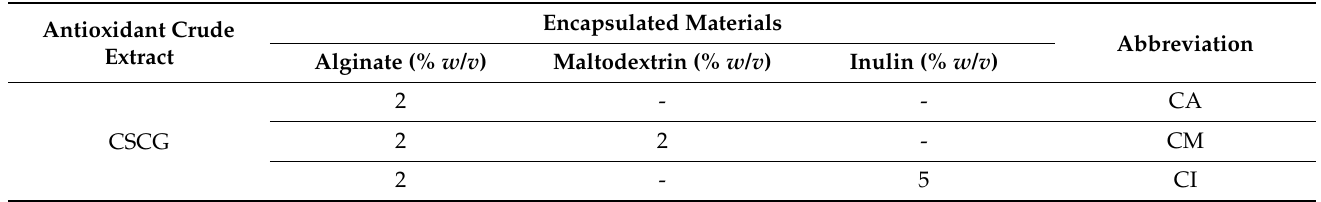
(2%, w/v ) or inulin (5%, w/v ) was added and mixed using a magnetic stirrer for 10 min at room temperature before the alginate (2%, w/v ) was added into the mixed solution. Table 1. Ratio of antioxidant crude extract and encapsulated materials (alginate, alginate/ maltodextrin, and alginate/inulin). Antioxidant